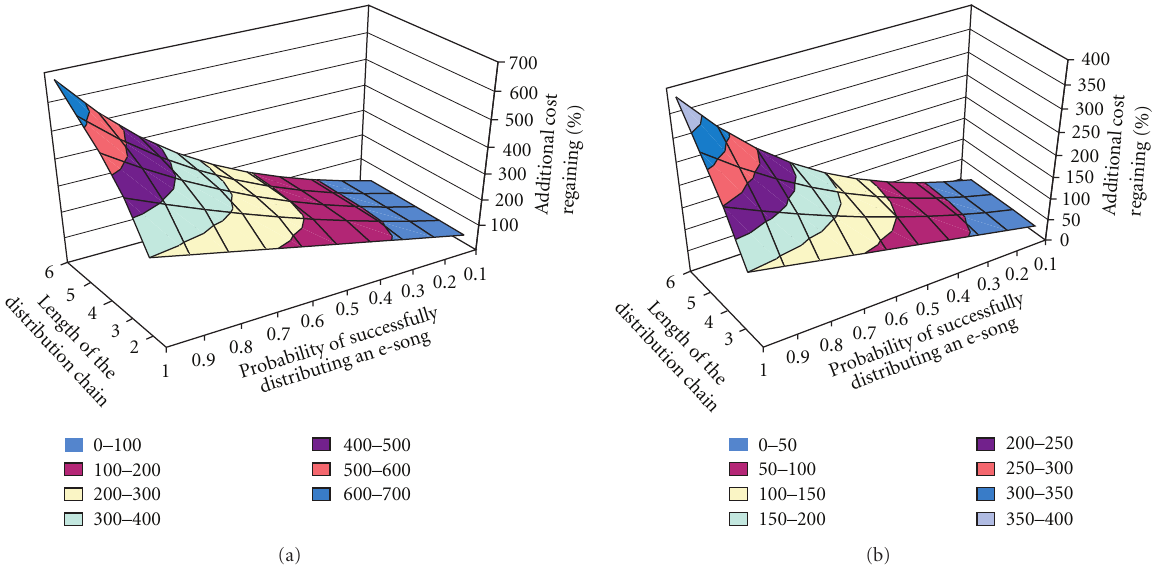
Figure 8: Additional cost regaining for the first (a) and second (b) members in the distribution chain by supposing three friend per member.